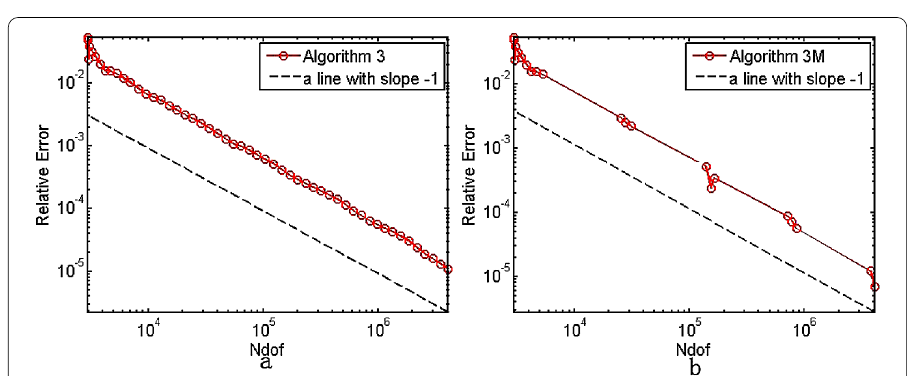
Figure 3 The convergence rates of the smallest eigenvalue from Algorithm 3(a) and Algorithm